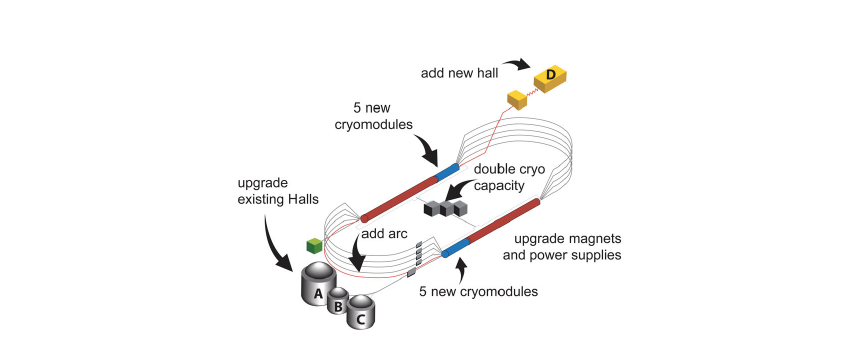
Figure 1. Je ff erson Lab 12 GeV upgrade